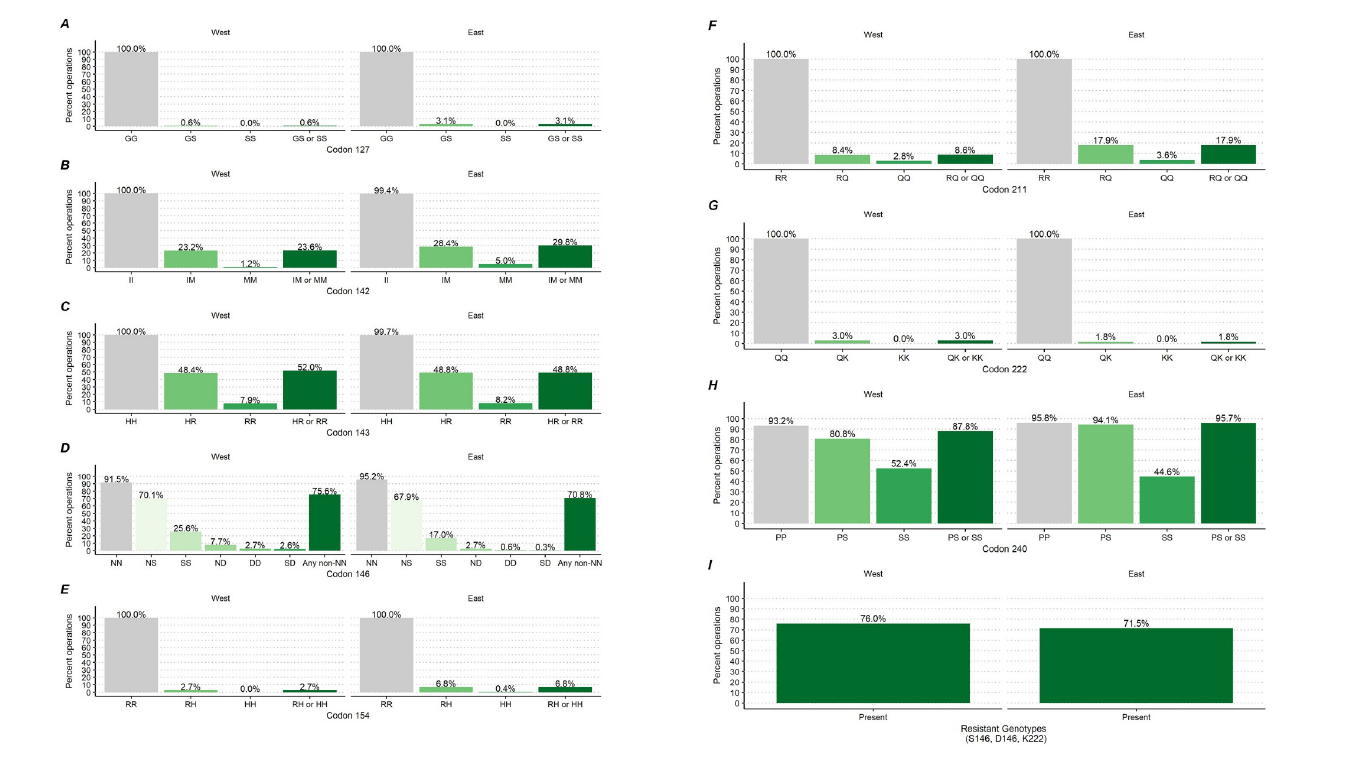
Fig 8. Percentage of goat operations by caprine PRNP polymorphic variants at codons 127, 142, 143, 146, 154, 211, 222 and 240 and by region.